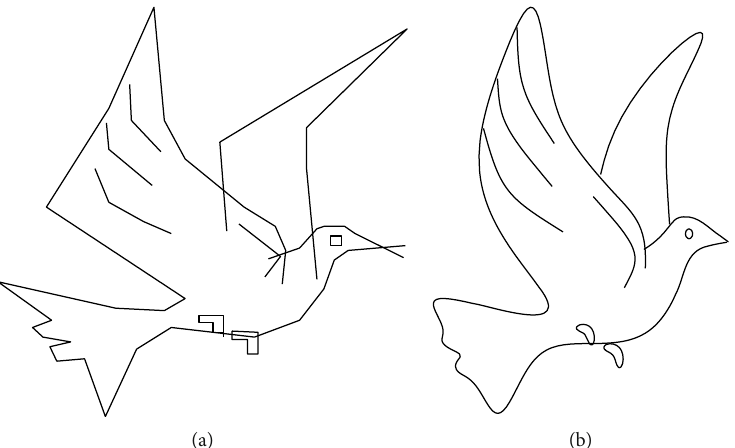
Figure 6: Application of R